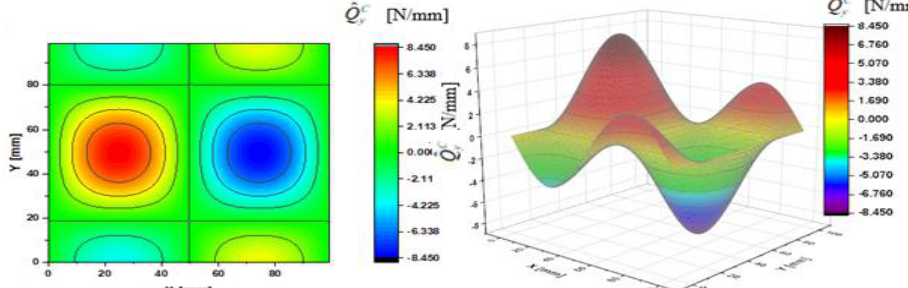
Figure 3. Contour-plane chart of ˆ Q C y for Case A.